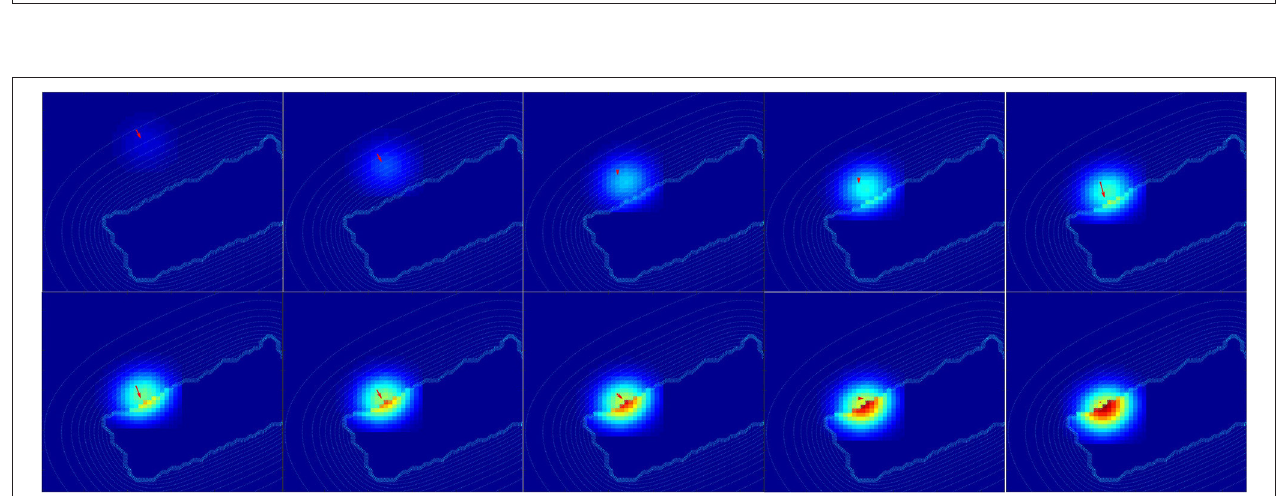
FIGURE 14 | Spatial receptive fields and relative visual orientation of arm-centered GF neurons. Activity of arm-centered GF neurons relative to the target location for trajectory A.